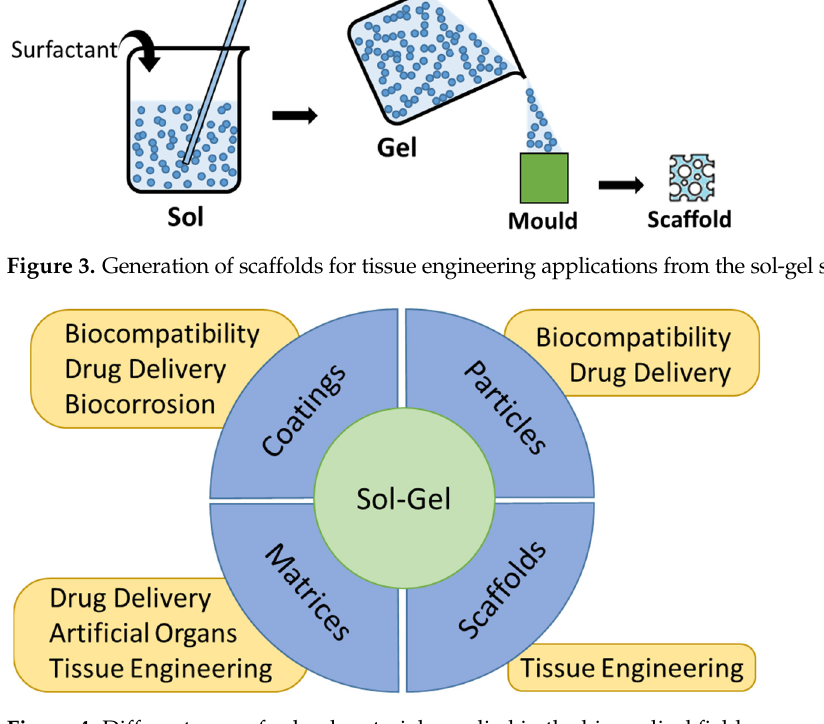
Figure 4. Different uses of sol-gel materials applied in the biomedical field.